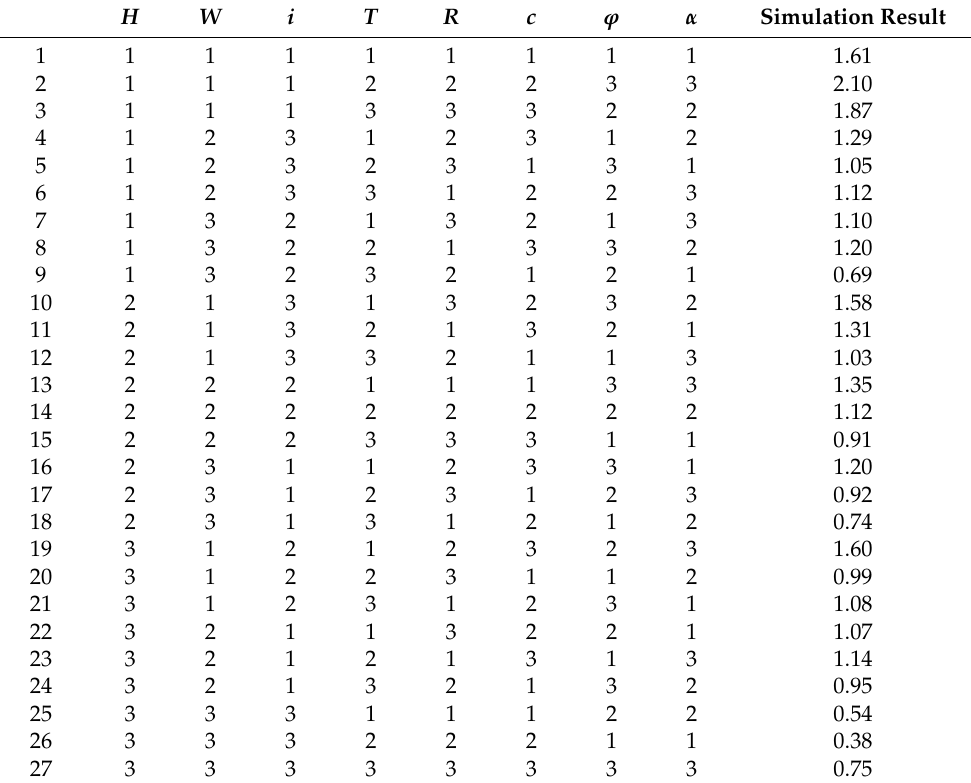
Table 10. Orthogonal table of a horizontal combination of the L 27 (3 8 ) parameters and the calculated slope stability